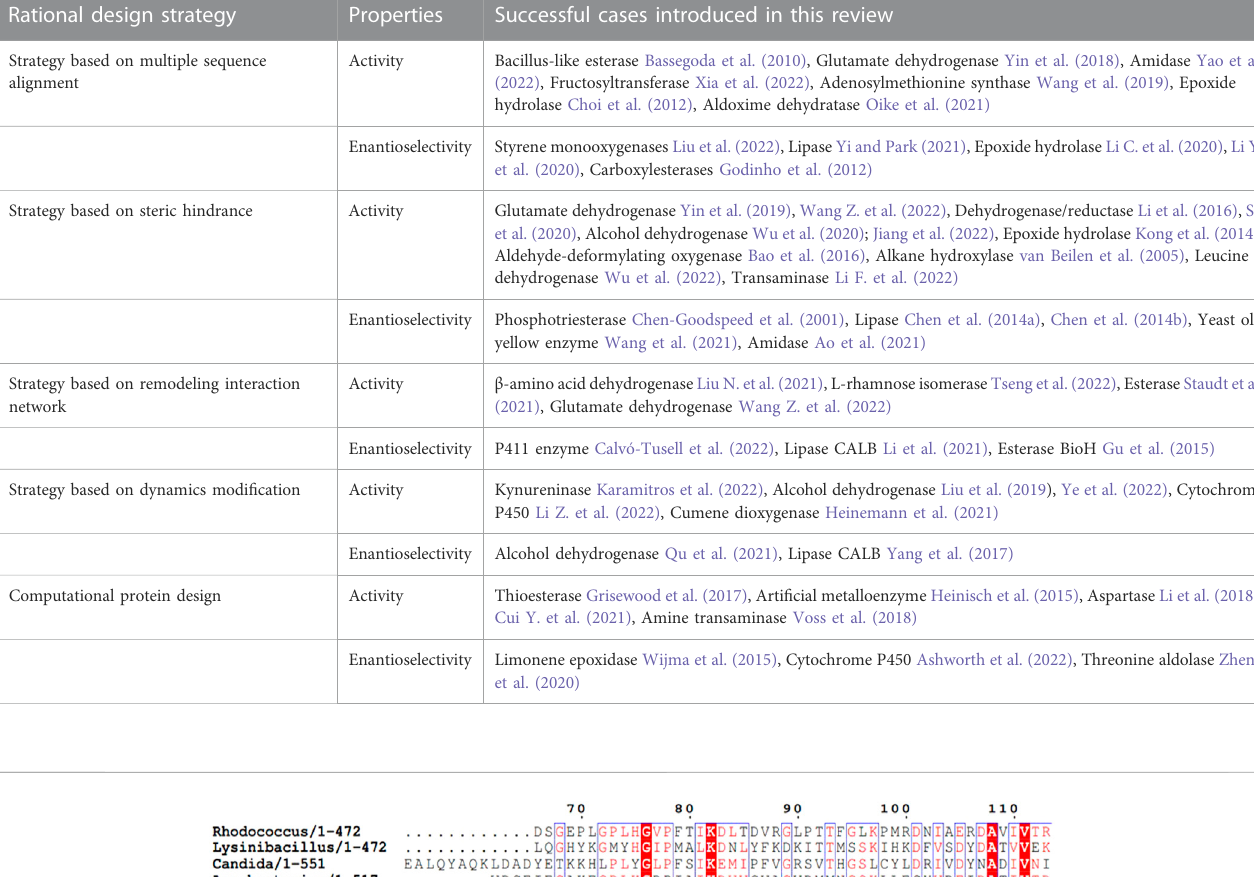
TABLE 1 The rational design strategies to engineer activity and enantioselectivity of enzymes.